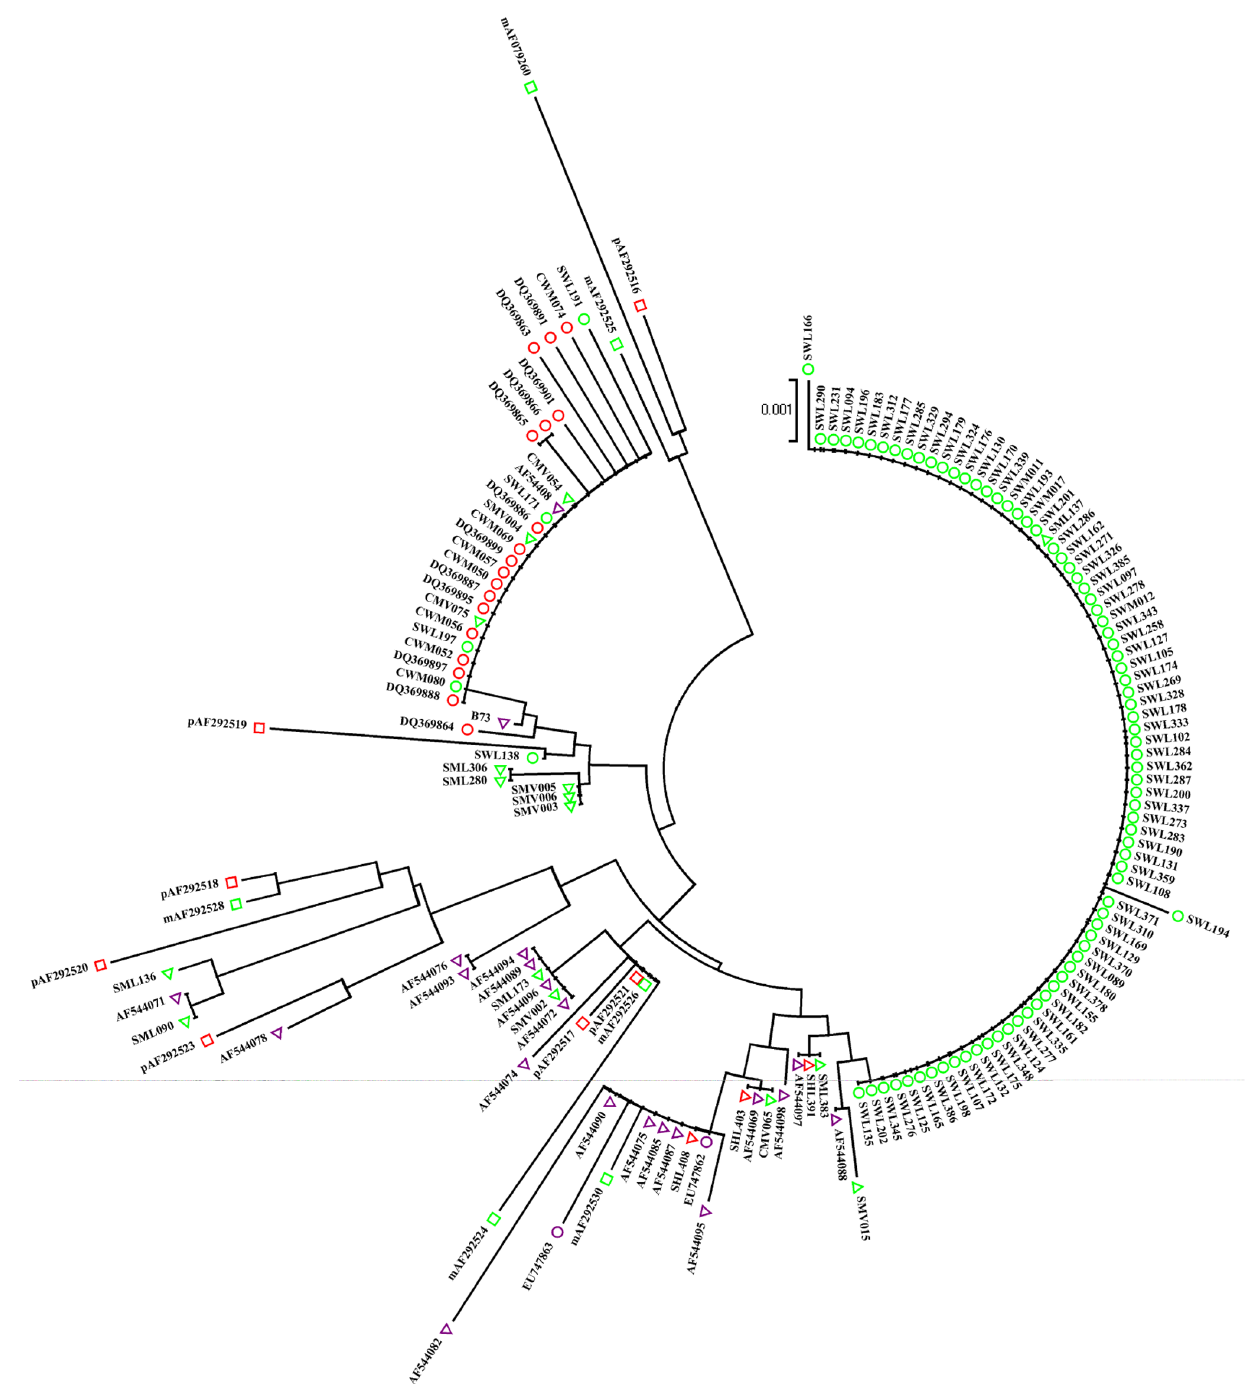
Figure 3. Phylogenetic tree of the Chinese waxy maize accessions based on waxy gene. The waxy maize from Southwest China, East China and America are shown with red, green and purple circles, respectively. The sweet maize, flint maize from China and flint maize from America are shown with red, green and purple triangles, respectively. Wild maize Zea mays spp. parviglumis and Zea mays spp. mexicana are shown with red and green squares, respectively.